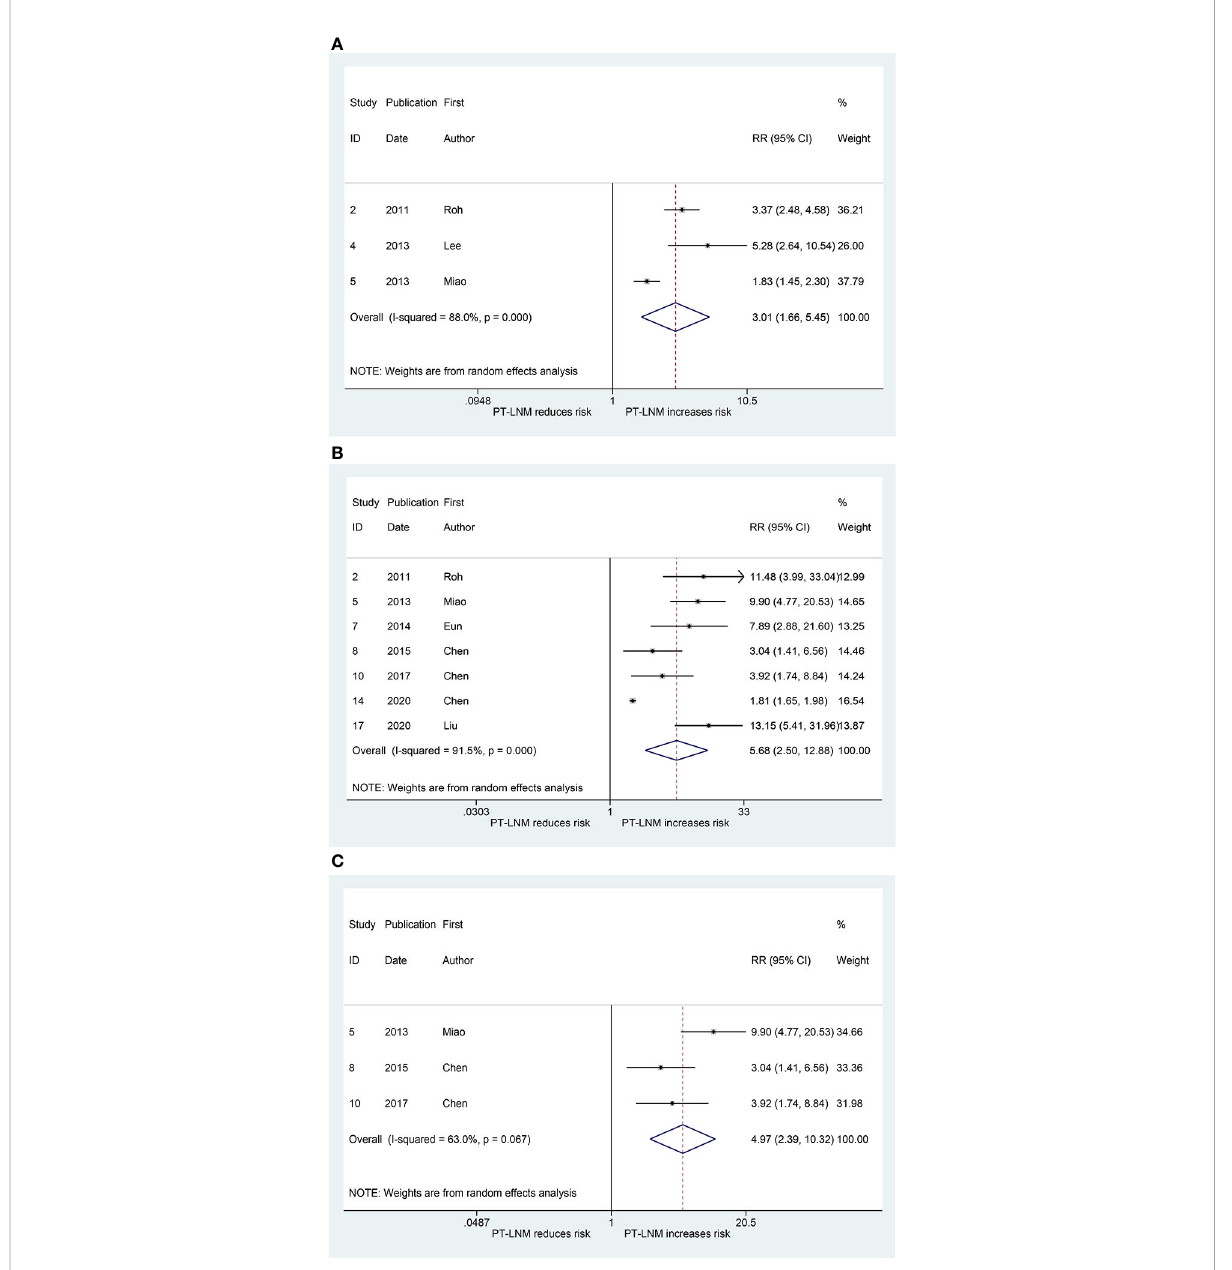
FIGURE 2 The relative risk for other groups ’ lymph node metastasis in patients with pretracheal lymph node metastasis (PT-LNM). (A) Ipsilateral paratracheal lymph node metastasis. (B) Contralateral paratracheal lymph node metastasis. (C) Contralateral paratracheal lymph node metastasis in patients with unilateral papillary thyroid carcinoma and clinical negative